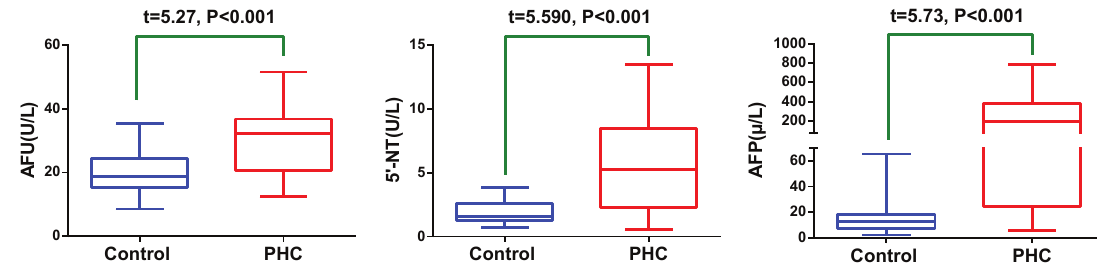
Figure 1: The box plot of serum AFU, 5’-NT and AFP of PHC and healthy control groups